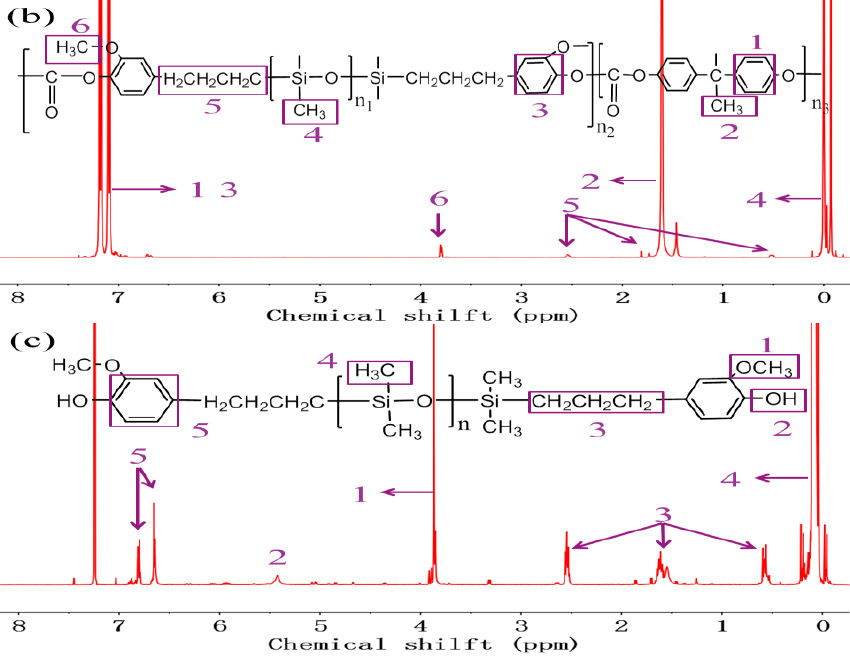
Figure 2. 1 H NMR spectrograms of 0%Si/PC ( a ), 20% Si/PC ( b ), and bio-phenol polysiloxane ( c ).